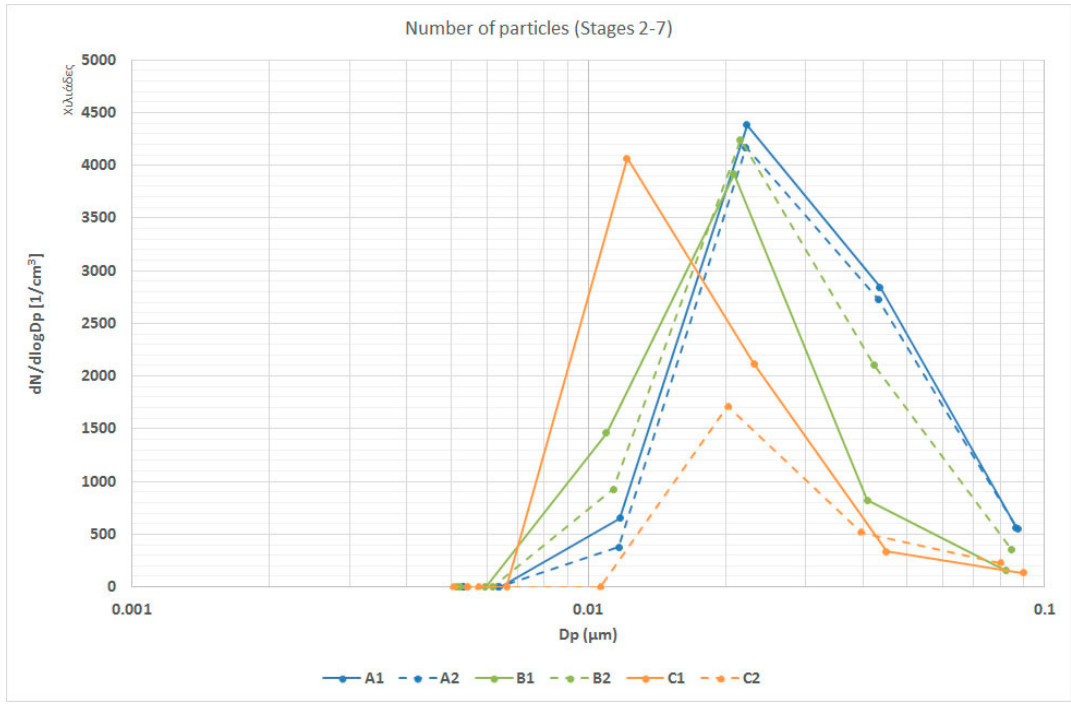
Figure 3. Number of particles emitted (1/cm 3 ) for sampling stages 2 to 7.